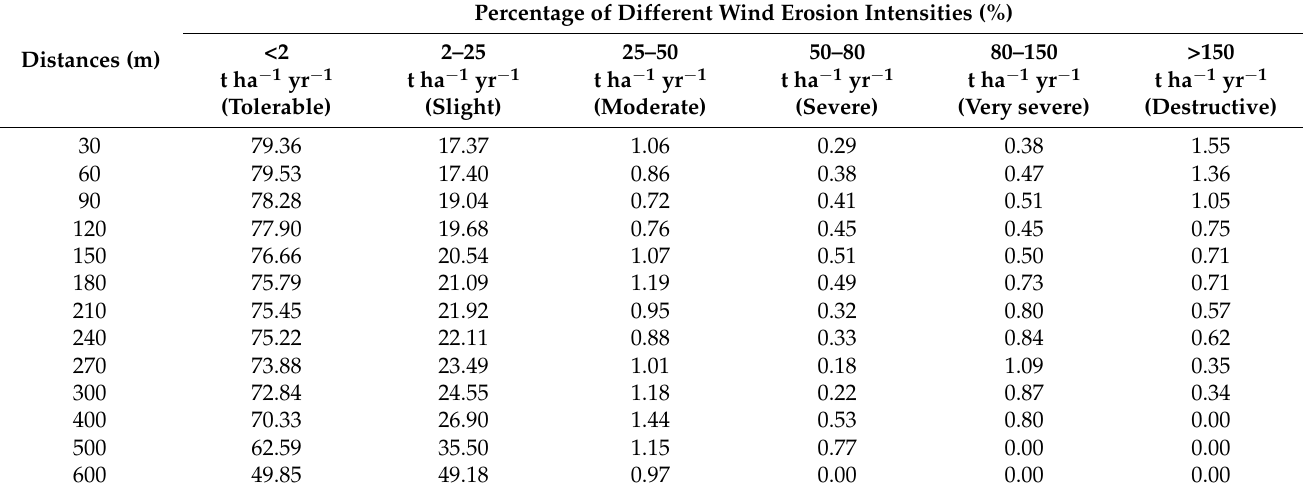
Table 1. Percentage of wind erosion intensities at different residence buffer